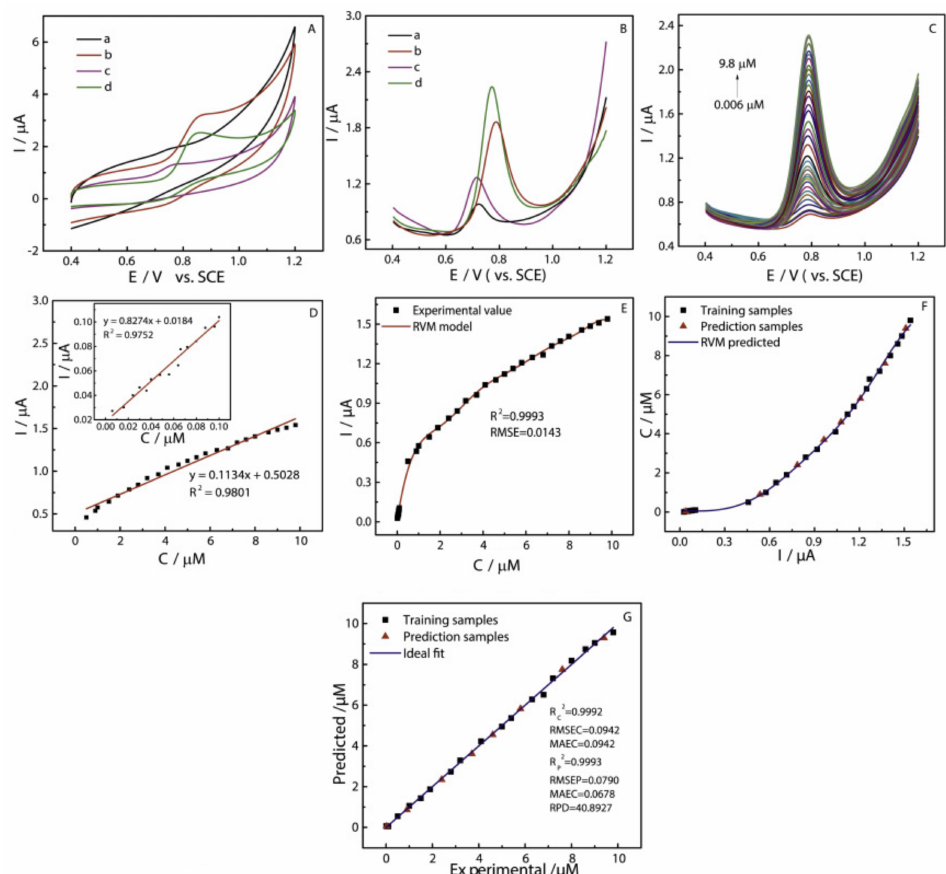
Figure 10. Electrochemical behaviors ( A ) of different modified electrode at the scan rate of 50 mVs − 1. ( B ) Corresponding DPV of CBZ at different modified GCE in 0.1 M PBS. ( C ) DPV of CBZ at Ti2C MXene/Au–Ag NS/GCE in 0.1 M PBS. The linear equation of CBZ ( D ) at different concentrations ranging from 0.006 to 9.8 µ M. RVM models with concentration as input ( E ) and current as input ( F ) for estimating CBZ concentration obtained by electrochemical. Comparison of the concentration experimental and RVM predicted values of samples ( G ). Reproduced from Reference [132] with permission. Copyright 2021,